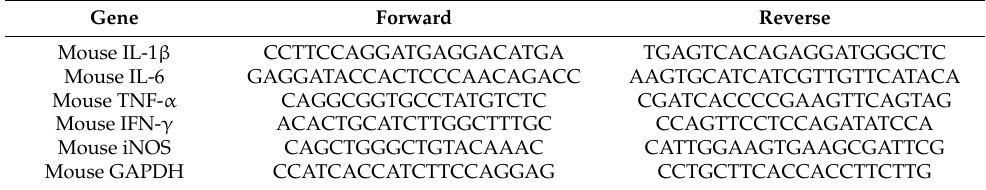
Table 3. Primer sequenced for